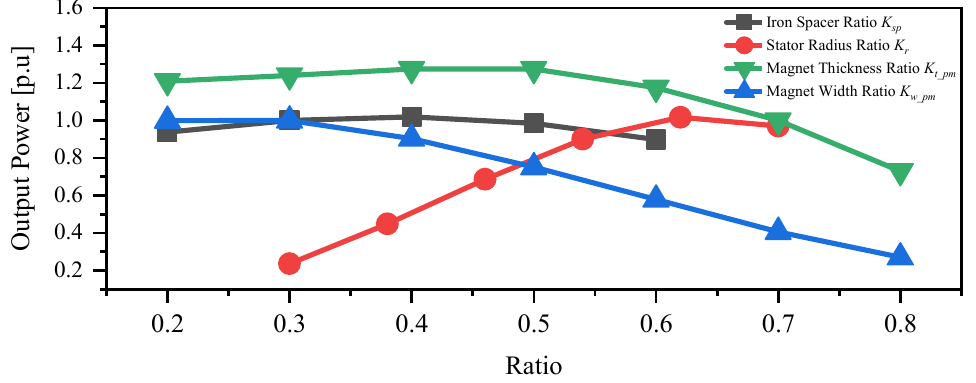
Figure 6. Variation average output power P out with design parameters.